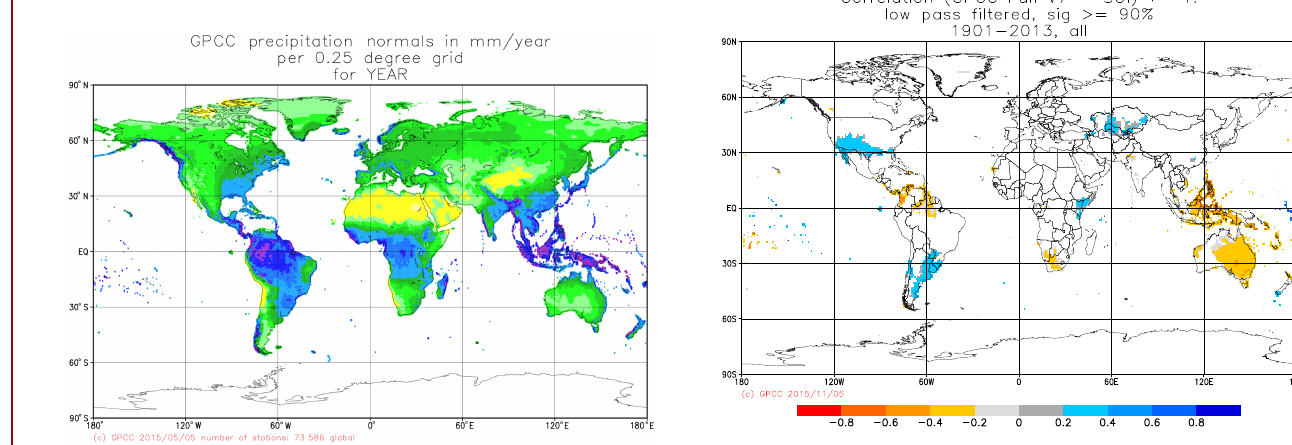
Figure 4. Centennial correlation between precipitation (GPCC Full Data Reanalysis V7) for the period 1901–2013 and the negative ENSO Southern Oscillation index ( − 1 × SOI) similar to Becker et al.